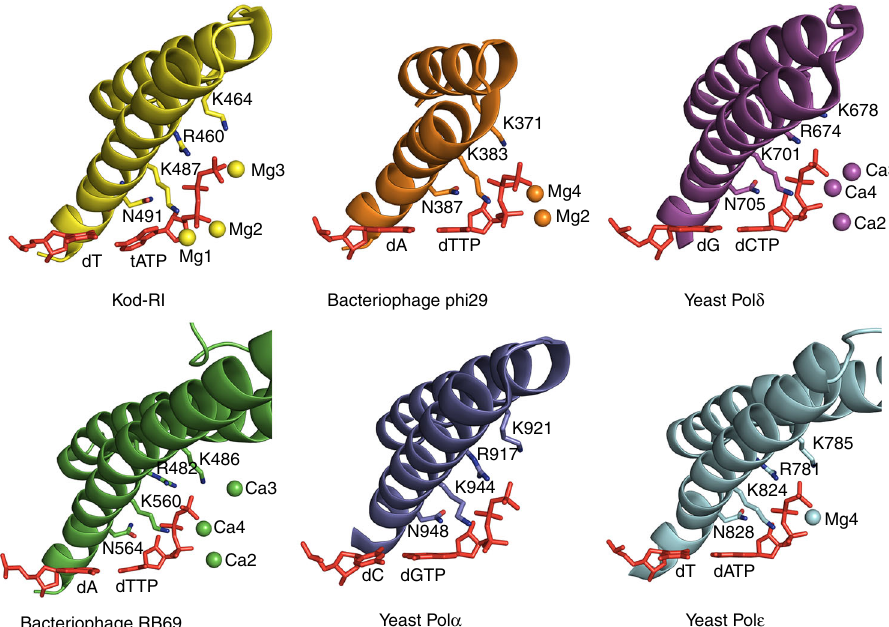
Fig. 6 Structural comparison of the fi nger subdomain for B-family polymerases. Conserved fi nger subdomain residues across archaeal (Kod-RI), viral (RB69, PDB: 1IG9 and Phi29, PDB: 2PYL), and eukaryotic (Pol α PDB: 4FYD, Pol δ PDB: 3IAY, and Pol ε PDB: 4M8O) polymerases interacting with the nascent base pair. In Kod-RI, Mg1 is novel, whereas Mg2 and Mg3 are observed in other B-family